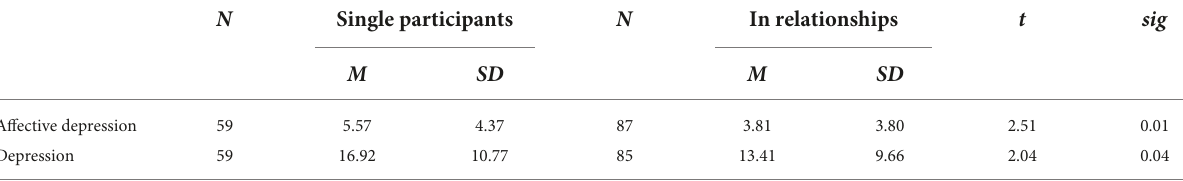
TABLE 3 Significant differences between single participants and those in relationships in changes in physical activity (PA) during epidemic and anxiety and depression. N Single participants N In relationships t sig M SD M SD